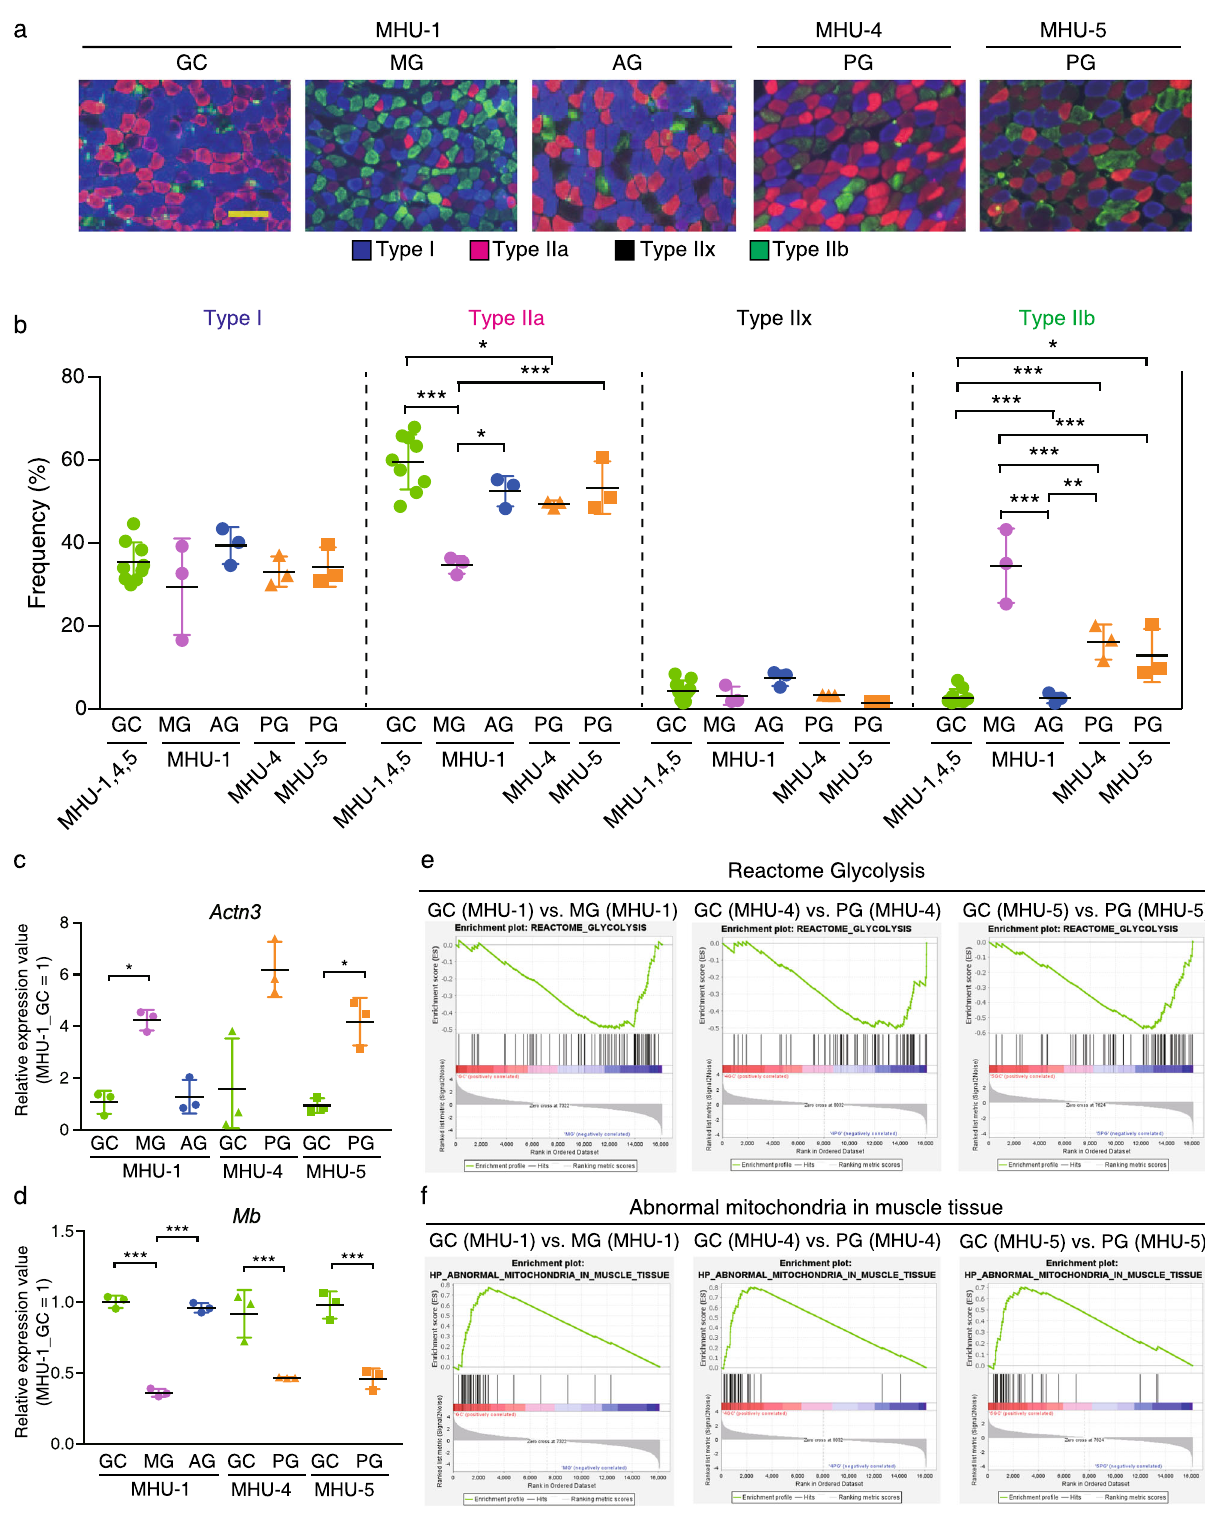
Fig. 5 Effect of lunar gravity on myo fi ber type in the soleus muscle. a Immunohistochemical staining for myosin heavy chain using BA-D5 (type I; blue), SC-71 (type IIa; red), and BF-F3 (type IIb; green) antibodies. Unstained myo fi bers are de fi ned as type IIx (black). Scale bar, 100 μ m. b Frequency of each myo fi ber type in all groups. Data are represented as the mean and SD, and each point represents an individual mouse; n = 9 for GC and n = 3 for all other groups. * P < 0.05, ** P < 0.01, and *** P < 0.001, as determined using Tukey ’ s tests. c Actn3 expression in the soleus muscle. d Mb expression in the soleus muscle. Expression values are normalized by transcripts per million (each GC = 1). Data are represented as the mean and SD, and each point represents an individual mouse; n = 3 for each group. * P < 0.05, ** P < 0.01, and *** P < 0.001 (false discovery rate-corrected), as determined using the edgeR test ( c , d ). e Gene set enrichment analysis (GSEA) of “ Reactome Glycolysis ” for each mouse habitat unit (MHU) mission. f GSEA of “ Abnormal mitochondria in muscle tissue ” for each MHU